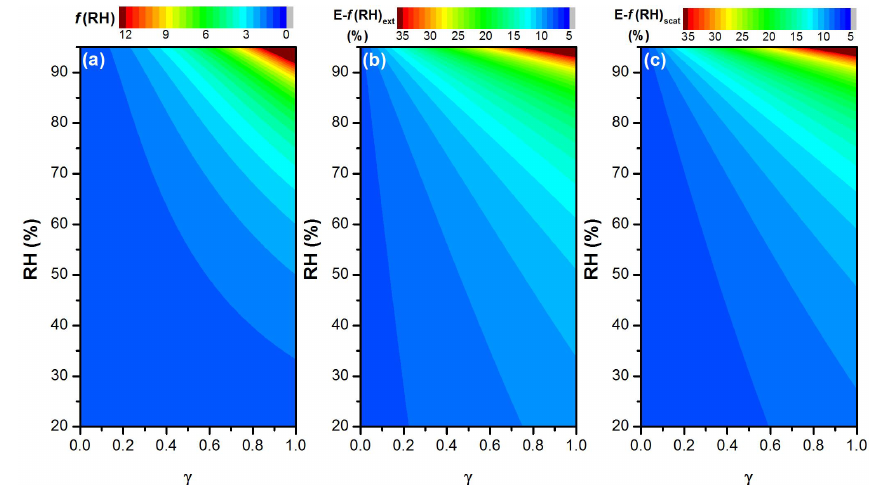
Figure 5. Simulated dependence of (a) f (RH) ext , scat , (b) error of f (RH) ext , and (c) error of f (RH) scat on the hygroscopic parameter γ and RH. The reference RH value was 20% RH in these simulations. Table 1. Comparison of the measured RH-dependent extinction and scattering coefficients for the size-selected ammonium sulfate and sodium chloride